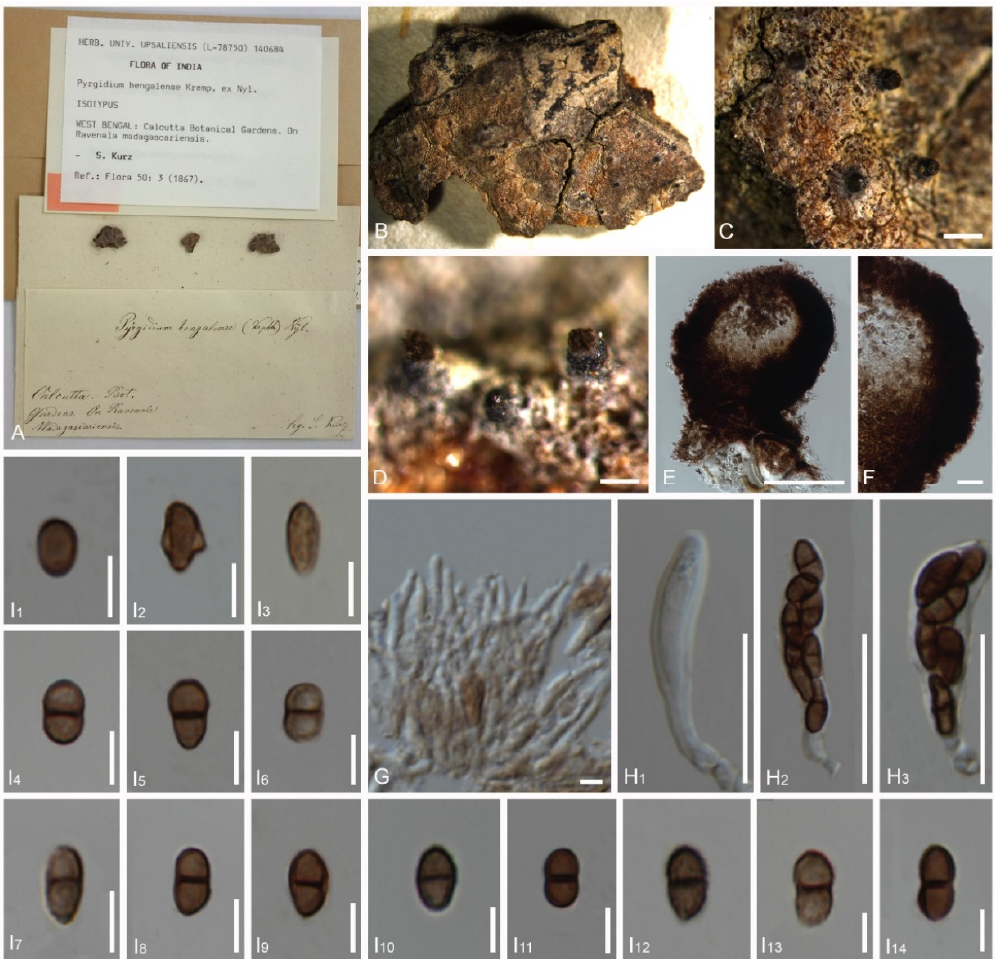
Figure 5. Pyrgidium montellicum (type material of P. bengaliense ) (Kurz 1866, Isotype) ( A ). Details of the herbarium specimen, ( B – D ). Ascomata on substrate, ( E ). Vertical section through the ascoma, ( F ). Vertical section through the exciple, ( G ). Paraphyses, ( H 1 – H 3 ) . Asci, ( I 1 – I 4 ). Ascospores (in water), ( I 5 – I 14 ). Ascospores (in 5% KOH). Scale bars: ( C ) = 500 µm, ( D ) = 200 µm, ( E ) = 100 µm, ( F ) = 20 µm, ( G ) = 5 µm, ( H 1 – H 3 ) = 20 µm, ( I 1 – I 14 ) = 5 µm. Description of the type Pyrgidium bengaliense : Saprobic on bark. Thallus inconspicuous, pruinose around the ascomata. Prothallus absent. Photobiont absent. Sexual morph: Asco- mata apothecial, 190–205 µm diam., 180–220 µm high (M = 197 × 200 µm, n = 10), not stalked, mazaedioid, with a black disc, sessile, scattered and almost spherical. Excipulum